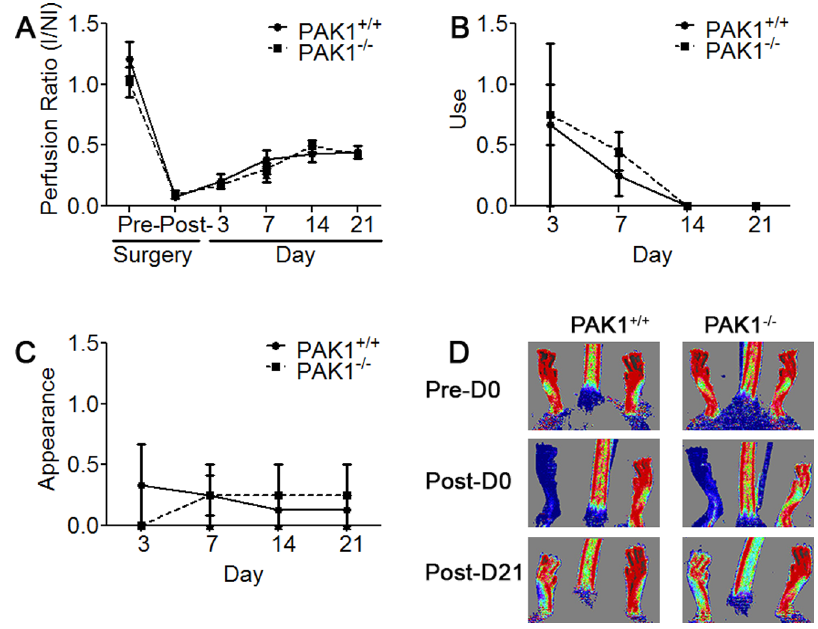
Figure 1. PAK1 2 / 2 plantar perfusion and function in model of severe HLI in 6–8 week-old mice is similar to PAK1 + / + mice. A) I/NI (Ischemic/Non-Ischemic) plantar perfusion ratio is comparable between PAK1 2 / 2 and PAK1 + / + mice as measured by laser Doppler imaging from day 0, immediately after HLI surgery, and throughout the 21 days after HLI surgery. B) Limb use score was determined as described in Materials and Methods and is equivalent between groups, where a higher score is observed within the first 2 weeks after surgery and decreased significantly thereafter, and indicating recovery of limb function. C) Appearance scores of PAK1 + / + and PAK1 2 / 2 mice were not statistically significant. D) Laser Doppler images obtained immediately following HLI surgery and on day 21 reflect a lack of difference in perfusion between PAK1 + / + (N=8) and PAK 2 / 2 (N=11) mice.